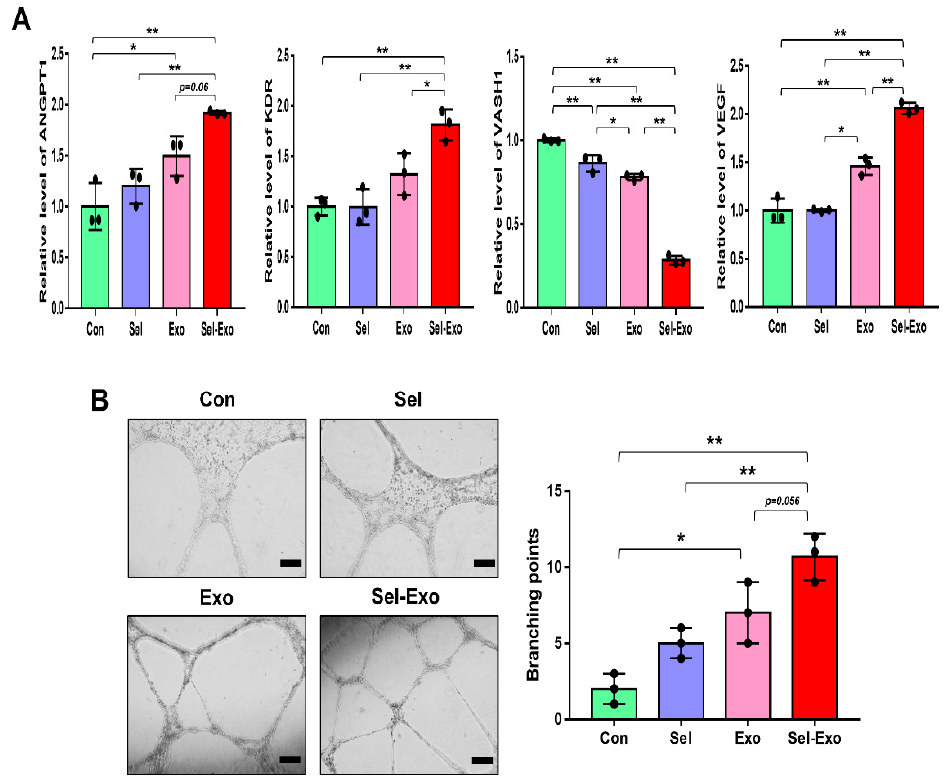
Figure 5. Effects of selenium, exosomes, and selenium-treated exosomes on angiogenic potential in vitro. ( A ) The expression levels of pro-angiogenic and anti-angiogenic mRNAs were evaluated by real-time PCR. ( B ) An in vitro tube formation assay was performed using Matrigel. Tube-like structures were observed using an inverted microscope (100 × magnification, scale bar = 200 µ m). A representative image of three independent experiments is shown. Data are expressed as the mean ± SD of three independent experiments. * Significant difference from control, p < 0.05. ** Significant dif- ference from control, p < 0.01.